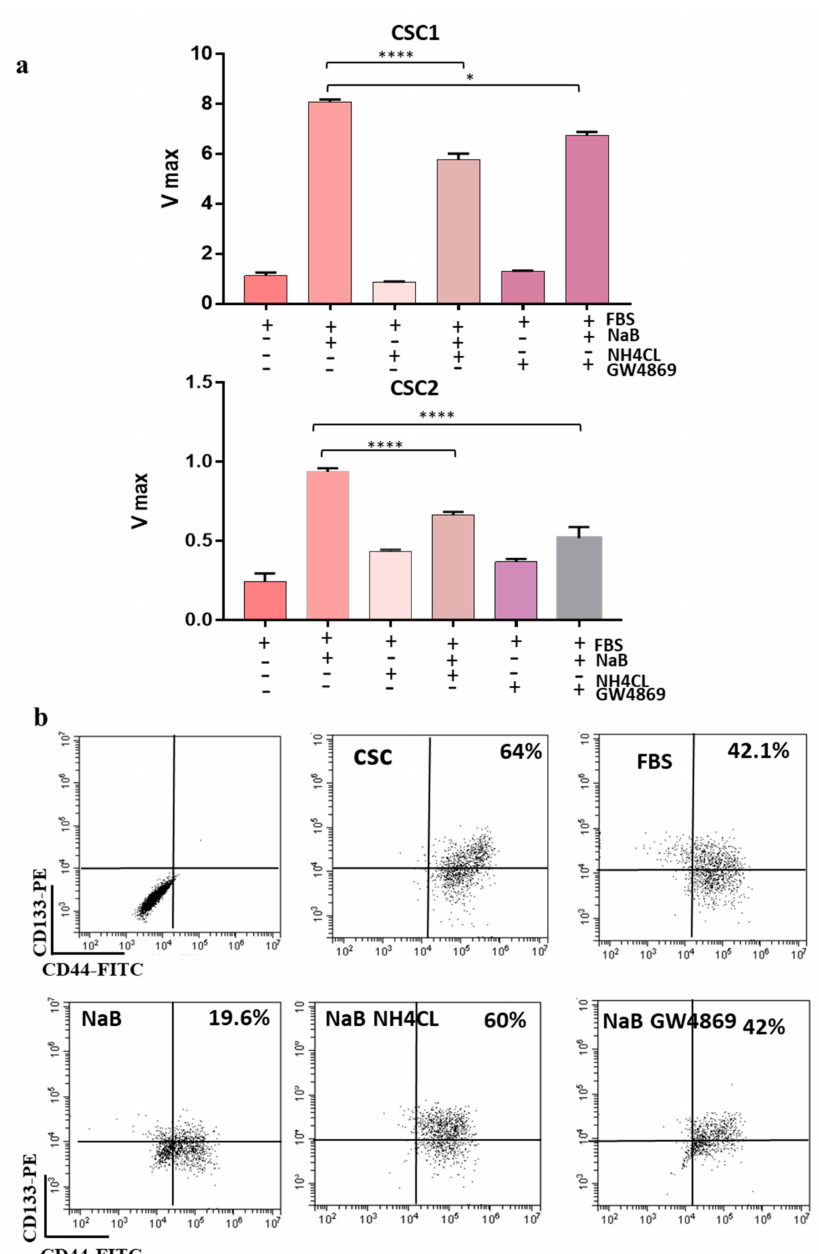
Figure 2. CR-CSCs Di ff erentiation Is Associated With sEVs Release. ( a ) Treatment with 20 mmol / L NH 4 Cl or with 10 µ mol / L GW4869, which block multivesicular body maturation, inhibits di ff erentiation of CR-CSCs Sa41 and Re121, as assessed by evaluating ALP activity (Vmax) and ( b ) prevents the reduction of the percentage of CD133 / CD44 positive cells (from 19% to 60% and 42% for NH 4 Cl and GW4869, respectively) but similar results were obtained with the other CR-CSC lines tested in this study (Figure S3). CSC = cancer stem cells undi ff erentiated; FBS = CR-CSCs di ff erentiated with 10% FBS and in absence of growth factors; NaB = CR-CSCs di ff erentiated with 10% FBS, maintained in absence of growth factors and treated after seven days with 2 mM NaB for 48 h. NaB NH 4 Cl = CR-CSCs di ff erentiated with 10% FBS, maintained in absence of growth factors and treated after seven days with 2 mM NaB and 10 mM of NH 4 Cl for 48 h; NaB GW4869 = CR-CSCs di ff erentiated with 10% FBS, maintained in absence of growth factors and treated after seven days with 2mM NaB and 10 µ M of GW4869 for 48 h. *, p ≤ 0.05; ****, p ≤